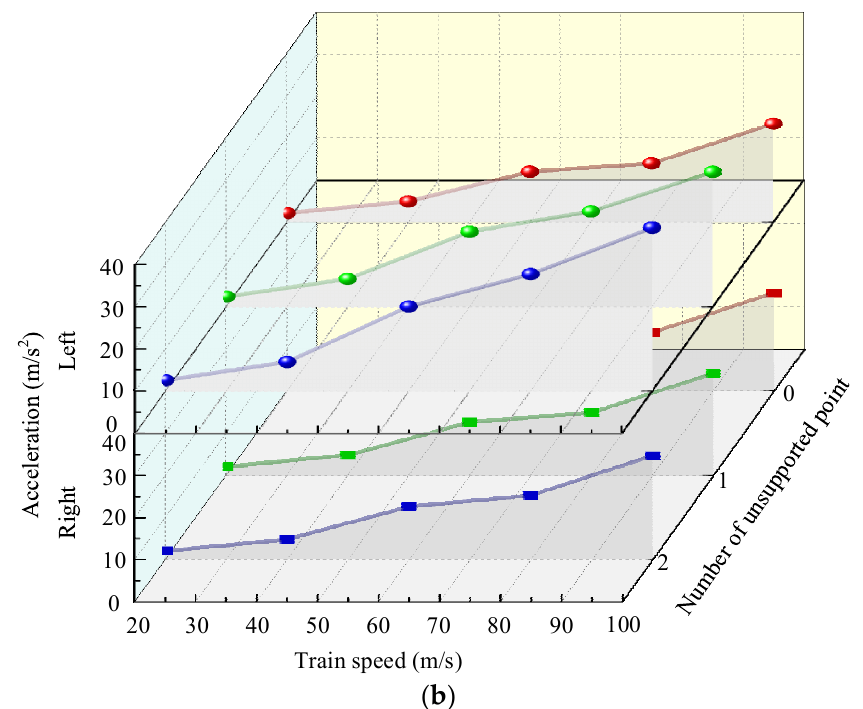
Figure 16. Effect of different speeds on dynamic response of point A under unilateral unsupported